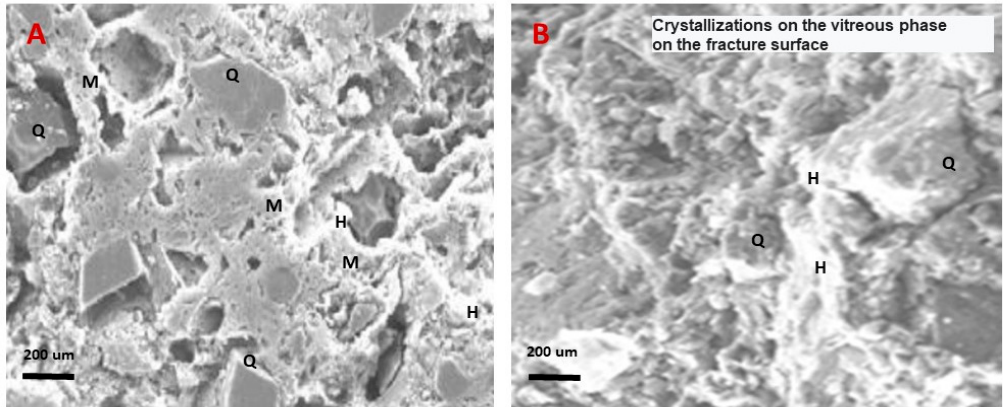
Figure 5. Growth of minerals, and presence of abundant vitreous phase and low porosity in tile bodies fired at 1150 ◦ C. ( A ) The presence of quartz and amorphous phase were observed together with small scale-shaped crystals of type I primary mullite ( < 0.2 µ m in size). ( B ) Crystallizations on the vitreous phase on the fracture surface. Hematite coatings are observed forming crusts. Table 5. Parameters that describe the porous texture of the ceramic tile bodies.